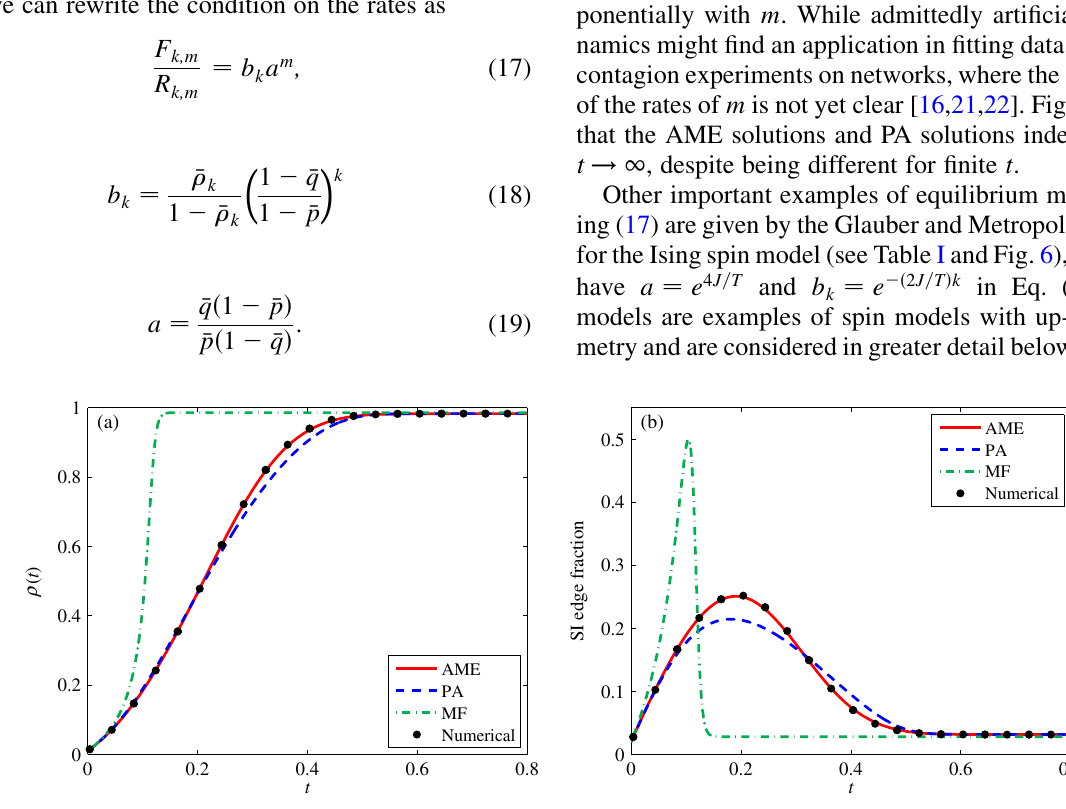
FIG. 5. Modified SIS-type model described by the rates (22) on a three-regular random graph. The parameters are (cid:1) ¼ 6 and (cid:2) ¼ 3 ; the initial state has (cid:5) ð 0 Þ ¼ 10 (cid:1) 2